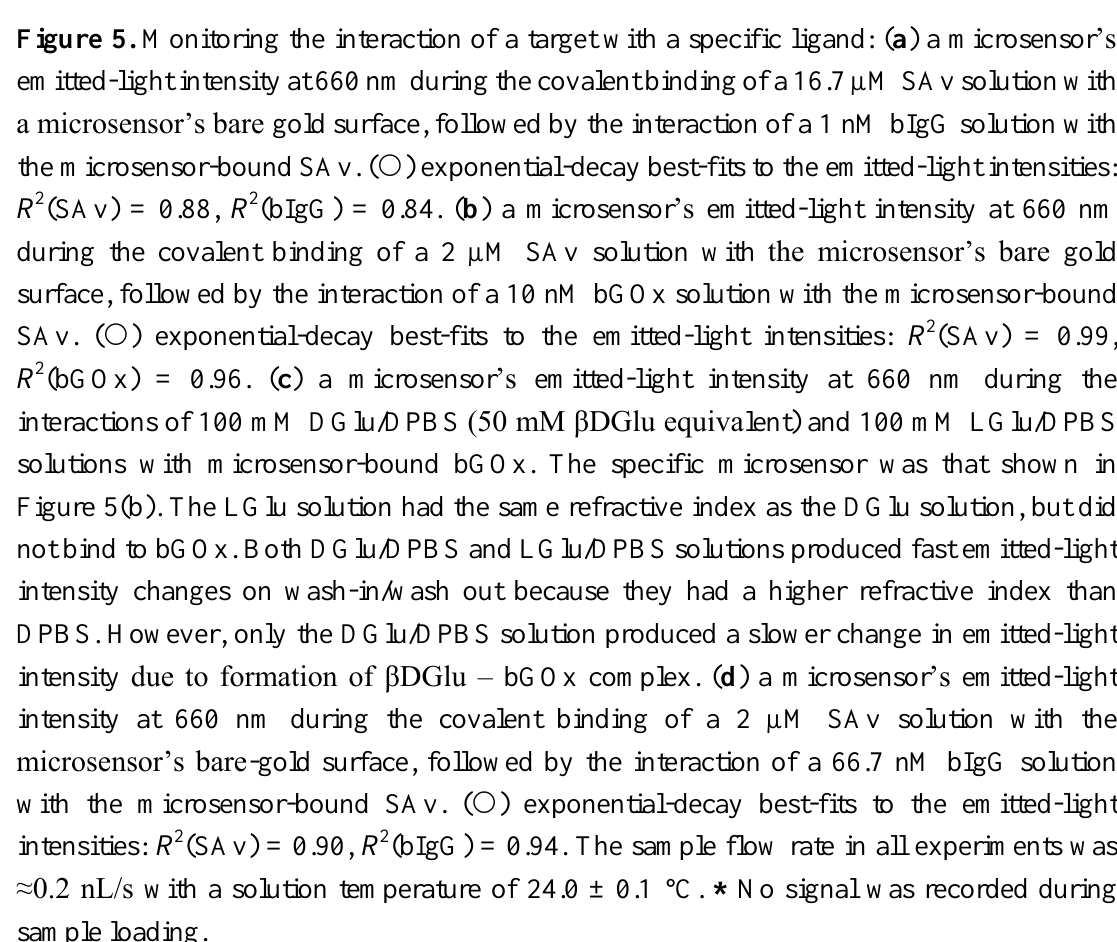
Figure 5. Monitoring the interaction of a target with a specific ligand: ( a ) a microsensor’s emitted-light intensity at 660 nm during the covalent binding of a 16.7 µM SAv solution